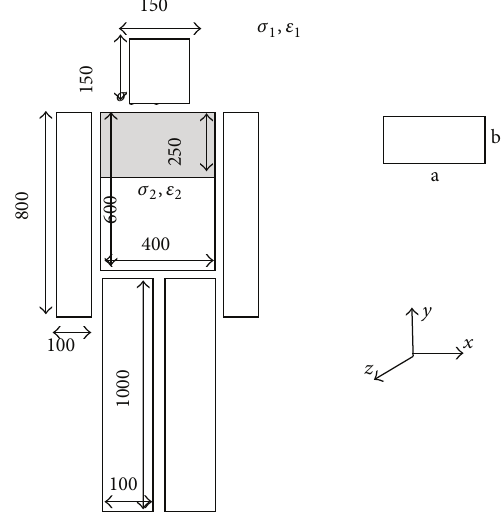
Figure 1: Scenario of the human body illuminated by an aperture antenna (dimensions are in mm). The respiratory activity is simu- lated by a volume variation of 1 liter of the grey